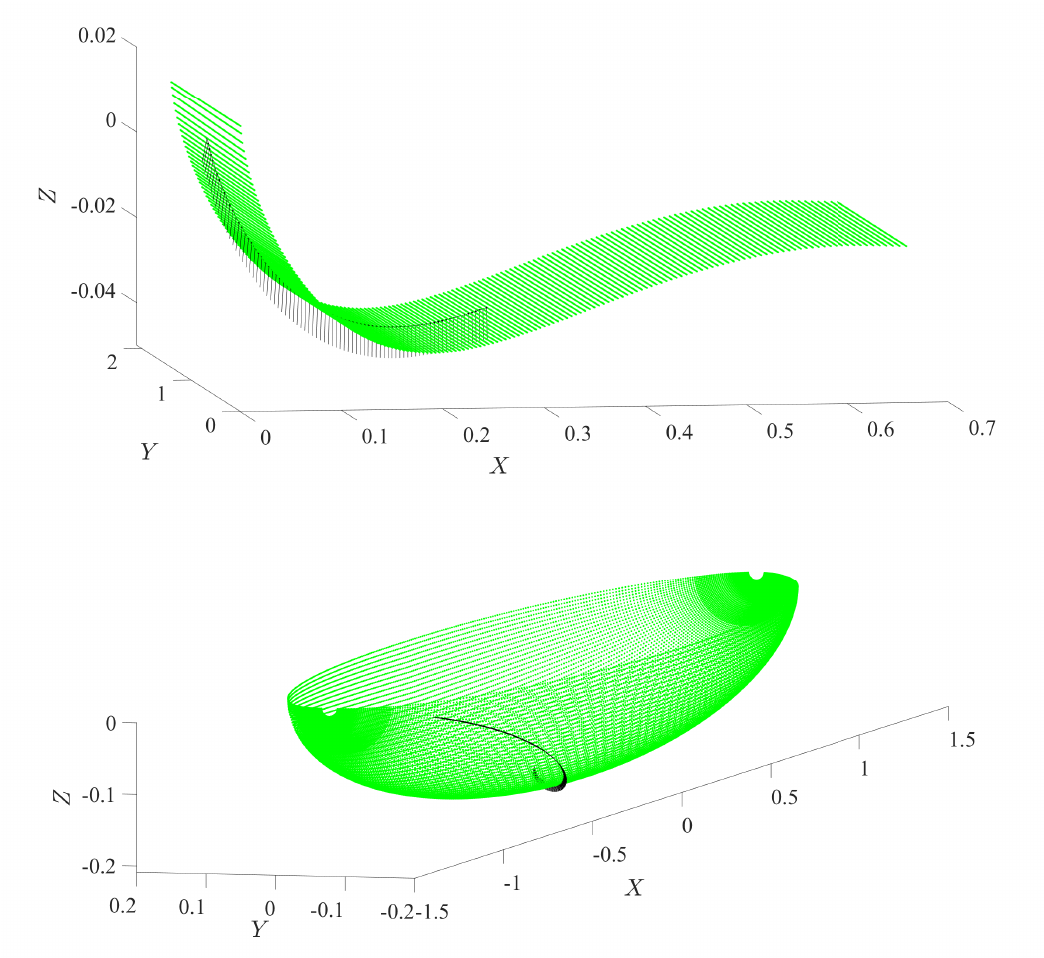
Figure 1. 3D configurations (green) and 2D slices (black) on them in the global Cartesian coordinates X , Y , Z : the lower side wing surface at U ∞ = 30 m/s, φ = 3 ◦ ( top ); half of the prolate spheroid at M ∞ = 0.7, φ = 10 ◦ rotated counterclockwise by 90 degrees ( bottom